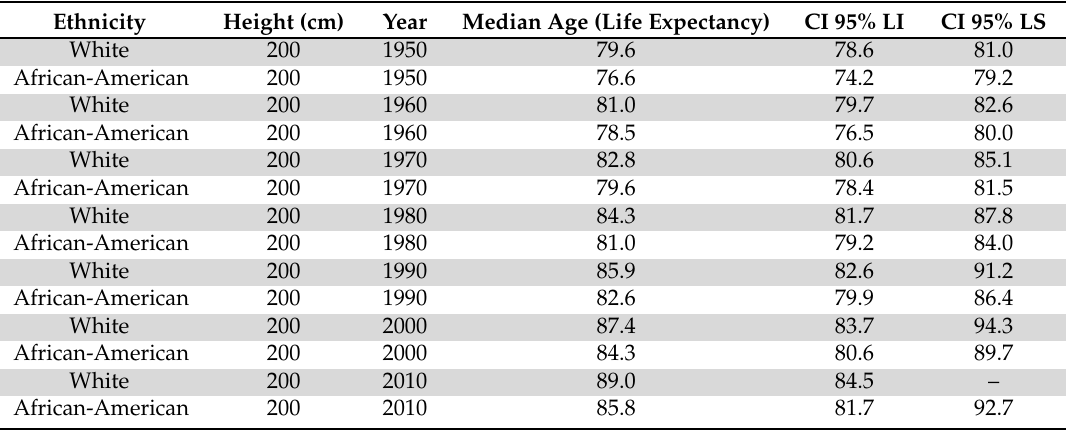
Table 3. Estimated median ages (and 95% confidence intervals) at death among NBA players of 2 m in height as a function of ethnicity and year of first NBA